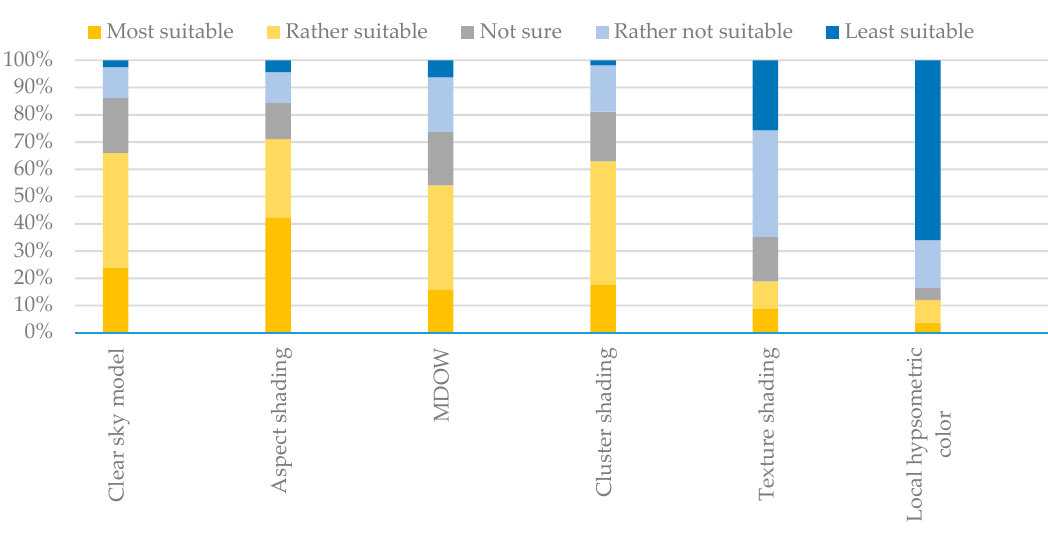
Figure 15. Survey results for glaciers.